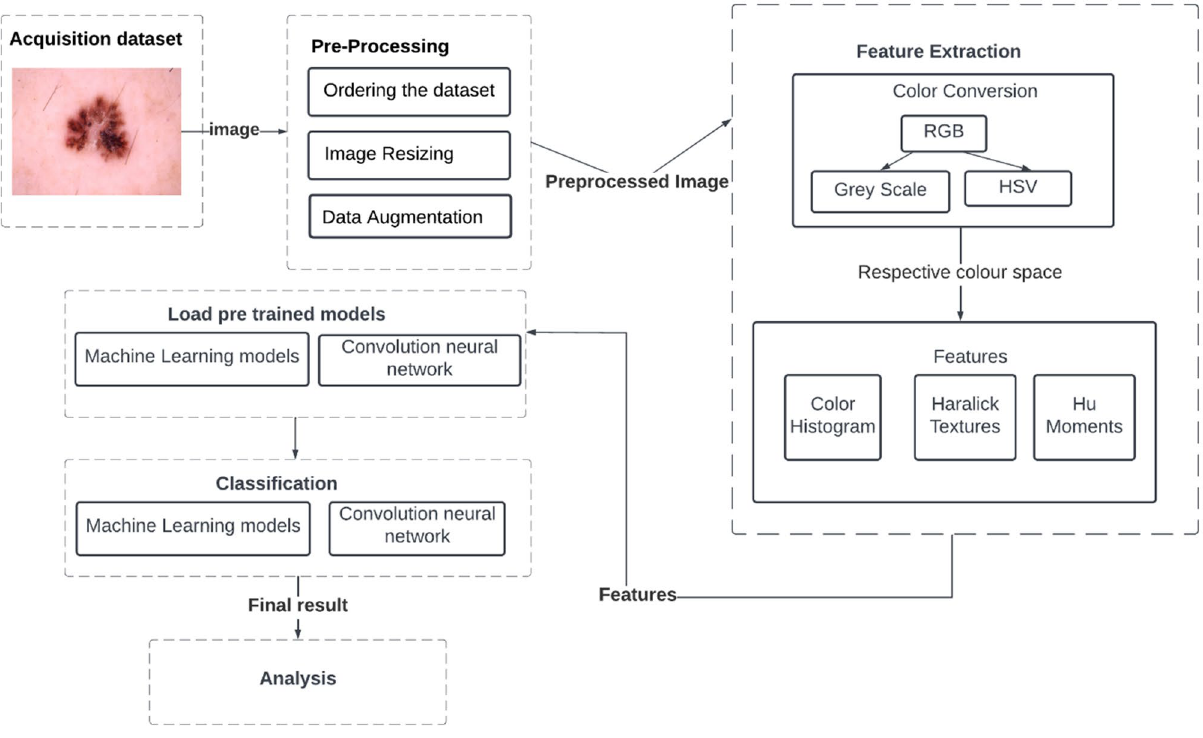
Figure 2. Flowchart of the ML Model.